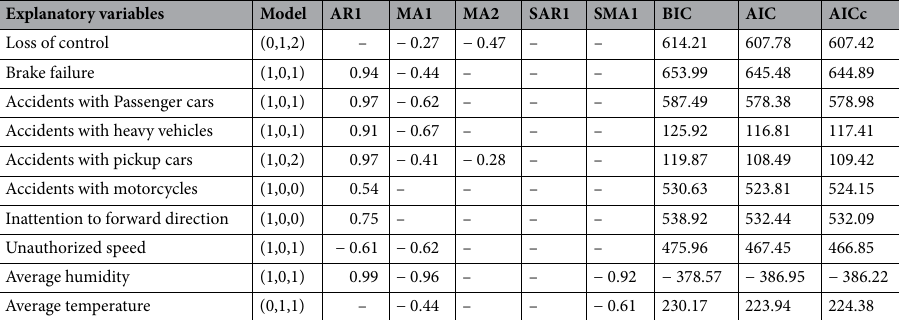
Table 4. Models related to independent variables, along with coefficients and goodness of fit criteria. AR1 first order autoregressive, MA1 first order moving average, MA2 second order moving average, SAR1 first order